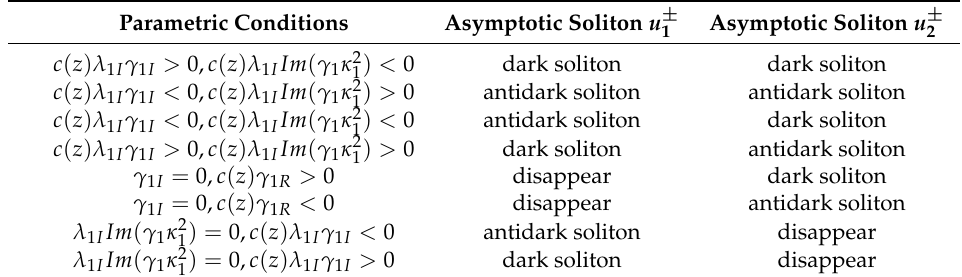
Table 1. Asymptotic patterns of the solution (19a) under different parametric